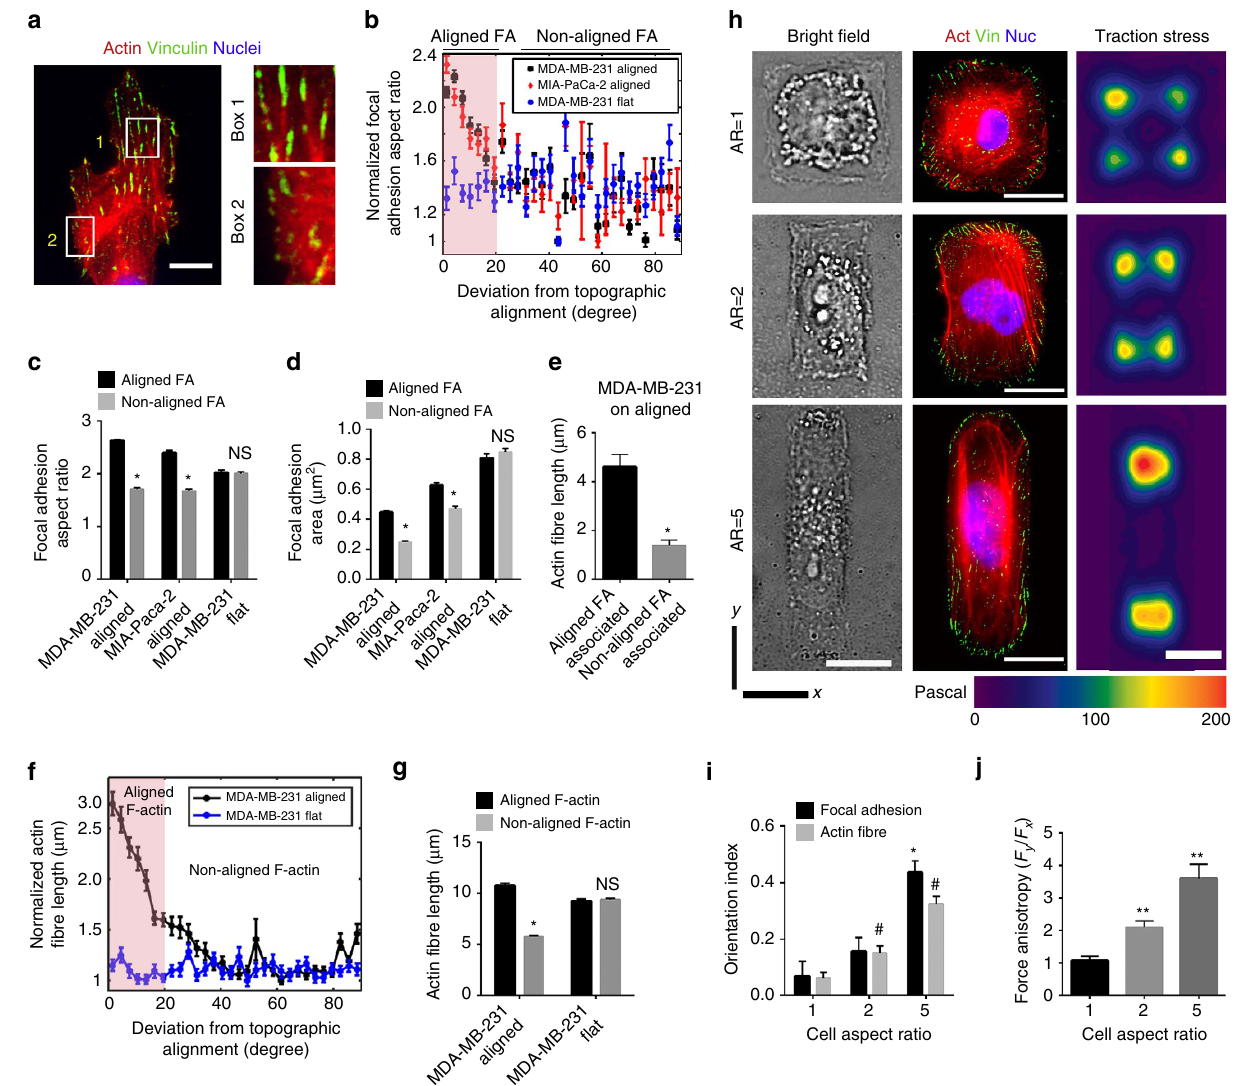
Figure 4 | Laterally constrained adhesion growth promotes orientation and anisotropic distribution of focal adhesions and traction forces. ( a ) Fluorescence micrograph of the leading edge of a typical MDA-MB-231 cell on an aligned substrate stained for F-actin (red) vinculin (green) and nucleus (blue). Magnified Box 1 and 2 show aligned FAs connected to long stress fibre-like F-actin cables, contrary to non-aligned FAs. Scale bar, 20 m m. ( b ) Normalized FA aspect ratio of MDA-MB-231 cells (on flat and aligned substrates) and MIA-PaCa-2 cells (on aligned) as a function of the corresponding FA orientations. Data are mean ± s.e.m., aligned FA: r 20 (cid:2) deviation from substrate alignment (pink region) and non-aligned FA (white region); (see Methods for additional details). ( c , d ) Aspect ratio ( c ) and area ( d ) of aligned and non-aligned FAs in MDA-MB-231 and MIA-PaCa-2 cells on aligned versus flat control substrates showing increased elongation and size of FAs oriented in the direction of topographic alignment ( n 4 400 adhesions per cell line). ( e ) Length of F-actin fibres connected to aligned and non-aligned FAs at the cell periphery ( n 4 180 fibres per group). ( f ) Normalized F-actin fibre length as a function of fibre orientations in MDA-MB-231 cells on aligned and flat substrates; data are mean ± s.e.m.; aligned F-actin: r 20 (cid:2) deviation from substrate alignment (pink region) and non-aligned F-actin (white region); (see methods for additional details). ( g ) Aligned F-actin fibres are longer than non-aligned F-actin fibres in MDA-MB-231 cells on aligned but not on flat substrates ( n 4 500 actin fibres per group). ( h ) Bright-field, fluorescence micrographs and traction stress maps ( n Z 7 cells per condition) of MDA-MB-231 cells patterned on ECM-coated islands in polyacrylamide gels with increasing aspect ratios (AR) of 1, 2 and 5. Scale bar, 20 m m. ( i ) Focal adhesion and actin fibre orientation indices showing increasing alignment with aspect ratio ( n 4 100 adhesions per condition; * P o 0.0001 between AR ¼ 5 and AR ¼ 1 or AR ¼ 2 groups; and n 4 400 fibres per condition, # P o 0.0001 between AR ¼ 5 and AR ¼ 1 or AR ¼ 2 and # P o 0.01 between AR ¼ 1 and AR ¼ 2 groups by ANOVA). ( j ) Force anisotropy in long axis ( y ) versus lateral ( x ) directions with increasing aspect ratio ( n 4 7 per condition; ** P o 0.01 for each pairwise comparison by Kruskal–Wallis test). Data in c – e , g , i , j are mean ± s.e.m., * P o 0.0001, NS: no significance (unpaired t